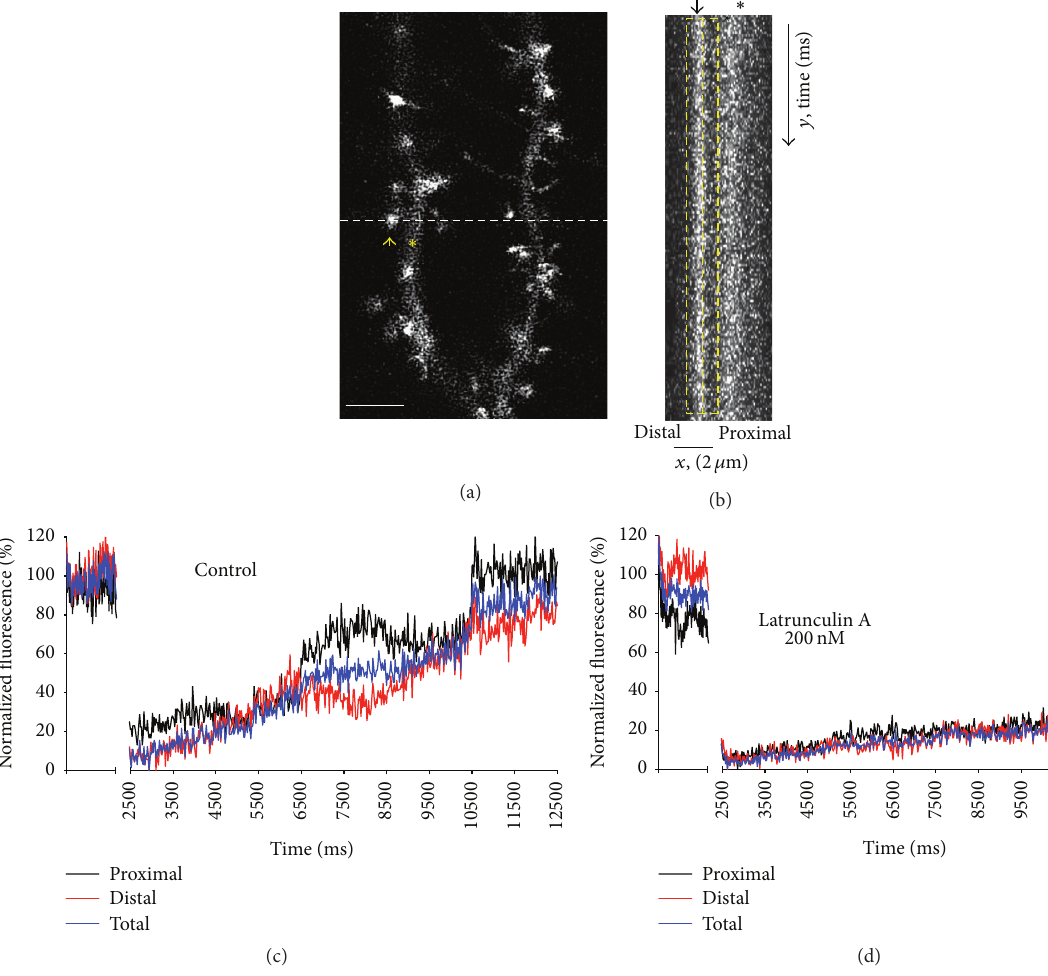
Figure 4: Spine head contains polymerization hot spots. (a) Example of spines from neurons in culture with astrocytes present, transfected with GFP-actin. The white line highlights the area selected for FRAP, employing a line scanning mode. In this mode, the scanned area is limited to the drawn line (around 200–300 nm wide). The spine is labeled with an arrow and the dendrite with an asterisk. Scale bar: 5 𝜇 m. (b) Section of a recovery image from the initial postbleach period, obtained with the lineal acquisition mode. The 𝑦 -axis corresponds to the acquisition time in ms (each line, 1ms) and the 𝑥 -axis corresponds to the localization in microns along the line. Spine and dendrite are marked with an arrow and an asterisk, respectively. Spine length was arbitrarily divided into two sections (highlighted by the yellow dashed box), corresponding to the distal and proximal part of the spine (notice how the proximal part includes the neck of the spine and a portion of the head). Scale bar: 2 𝜇 m. (c) Example of normalized fluorescence recovery curve of the spine in (b). The distal part of the spine (red) and the proximal area (black) were analyzed and plotted independently. The blue line shows the fluorescence recovery curve of the entire yellow box area (sum of distal and proximal areas). In this particular example, at the times when the distal area recovery rate drops, a proportional increase at the distal area is found. Therefore, the total average fluorescence recovery does not change (blue line). Out of the 25 spines analyzed, 13 (52%) showed differences in the recovery rate between the distal and proximal areas of the spine, as shown in the example. (d) Normalized fluorescence recovery curve after addition to the culture media of Latrunculin A (200 nM), an organic compound thatblocksactinpolymerizationbysequesteringactinmonomers.Noticethereductioninmobilefractionvalueandtheabsenceofdistributed